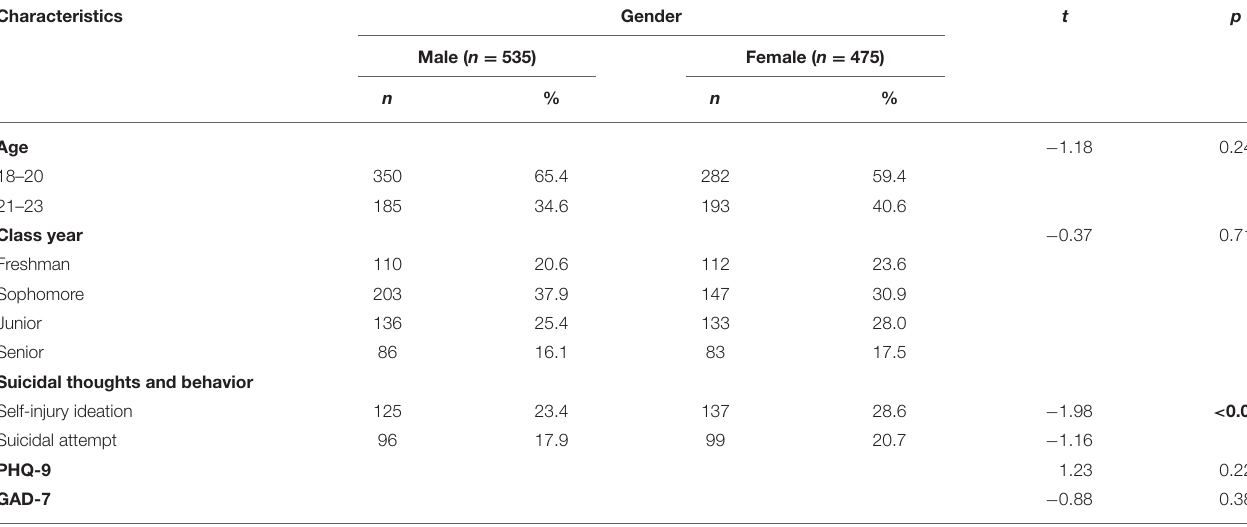
TABLE 1 | Descriptive information of male and female Chinese international college students ( n = 1,010). Characteristics